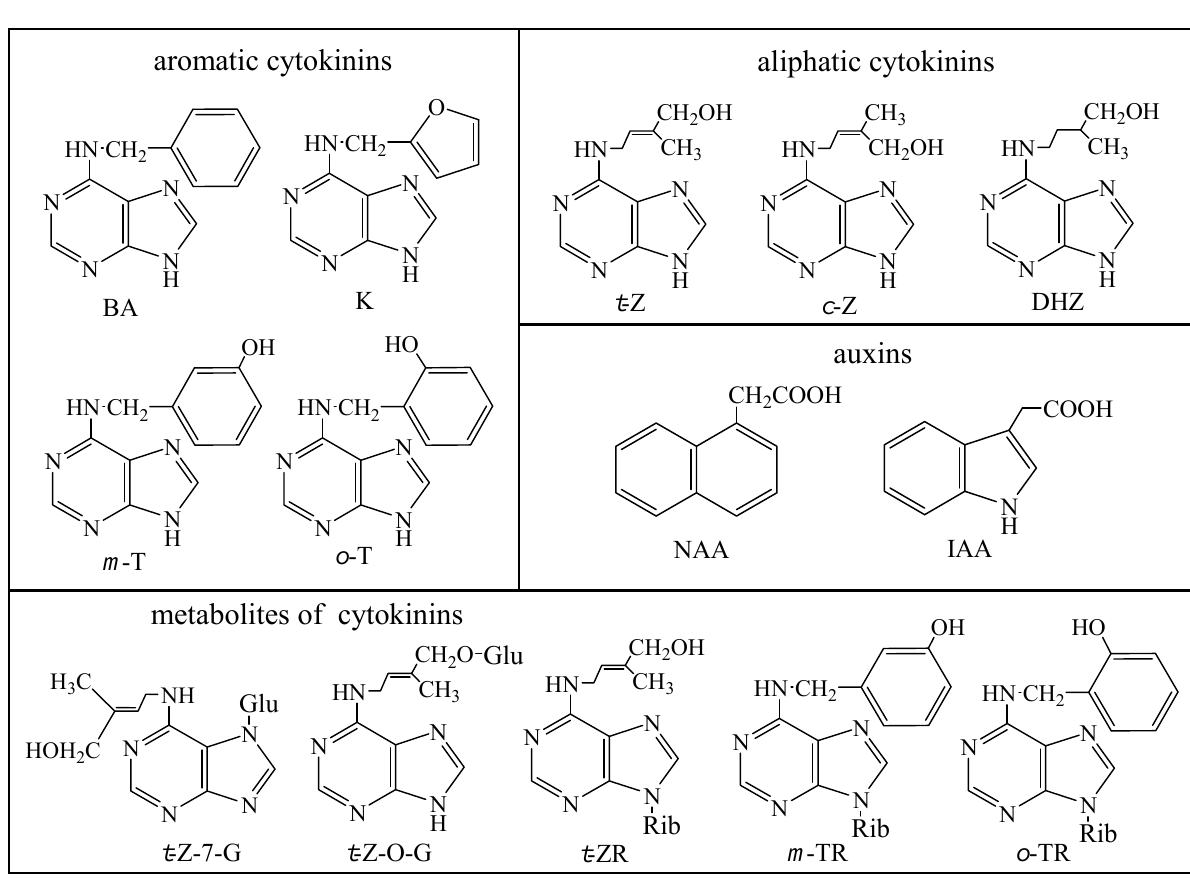
Figure 1. Chemical formulas of the phytohormones. BA = benzyladenine, K – kinetin, t -Z = trans -zeatin, c -Z = cis -zeatin, DHZ = dihydrozeatin, m-T = meta -topolin, o-T = ortho -topolin, NAA = α -naphthalene acetic acid, IAA = indole-3-acetic acid, t -Z-7-G = trans -zeatin-7-glucoside, t -Z- O -G = trans -zeatin-O-glucoside, t -ZR = trans - zeatin-9-riboside, m -TR = meta -topolin-9-riboside and o -TR = ortho -topolin-9-riboside. Rib = ribose, Glu =